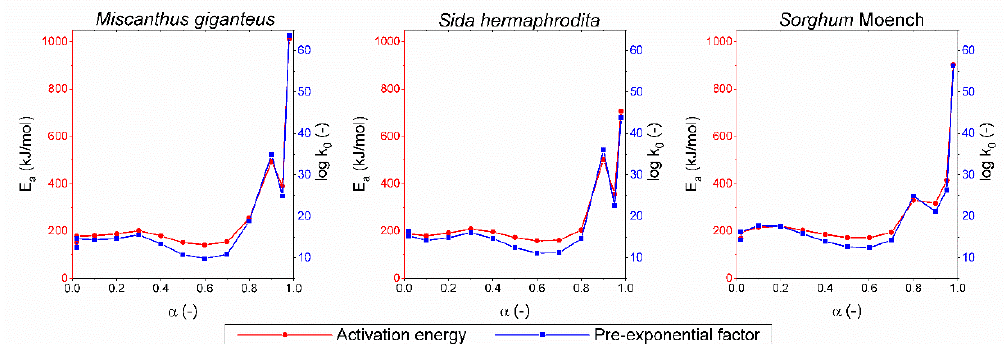
Figure 3. Friedman plots for energy crop decomposition.